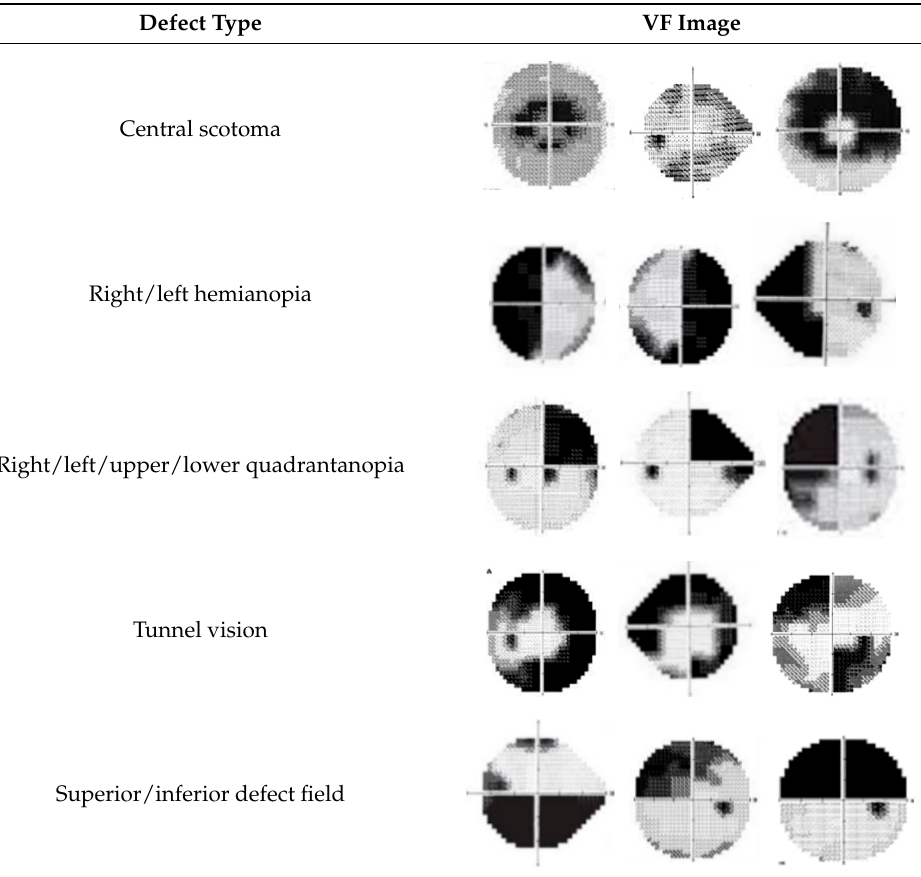
Figure 2. Normal VF Images: ( a ) HVF 10-2; ( b ) HVF 24-2. Table 2. Types of VF Defects.